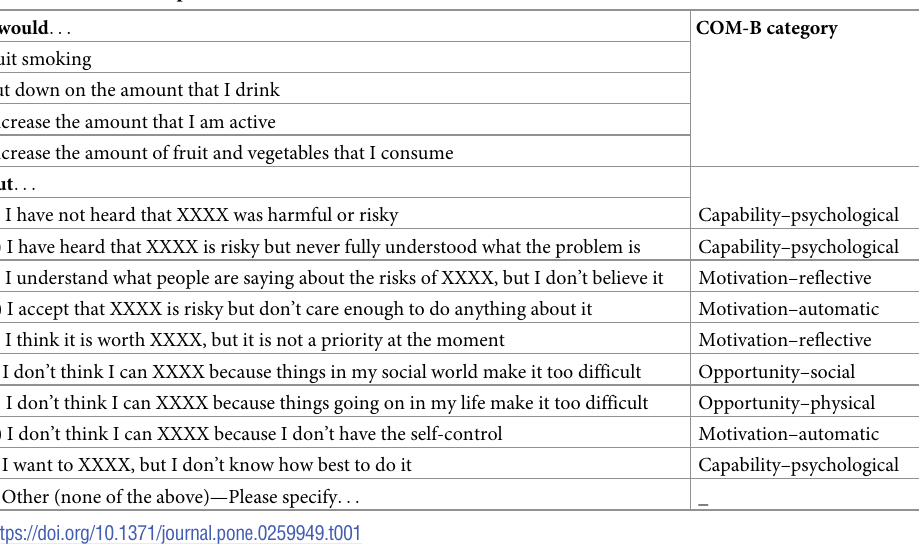
Table 1. The Risk Acceptance